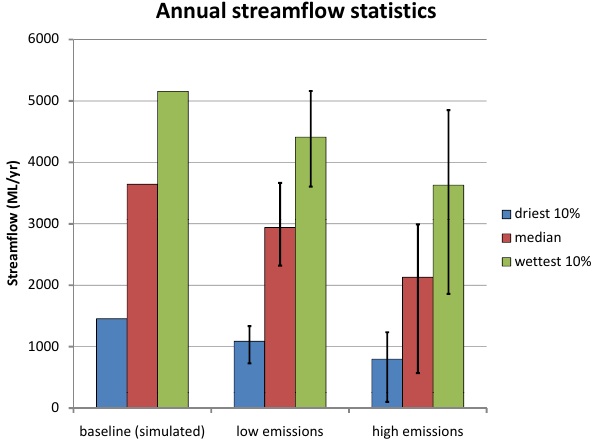
Fig. 8. Simulated streamflow (MLyr − 1 ) in dry years (10th per- centile), median years and wet years (90th percentile), for baseline, low emissions and high emissions scenarios. Coloured bars indicate GWLF model results using median climate model parameters; error bars indicate spread in GWLF model results from using upper and lower climate model